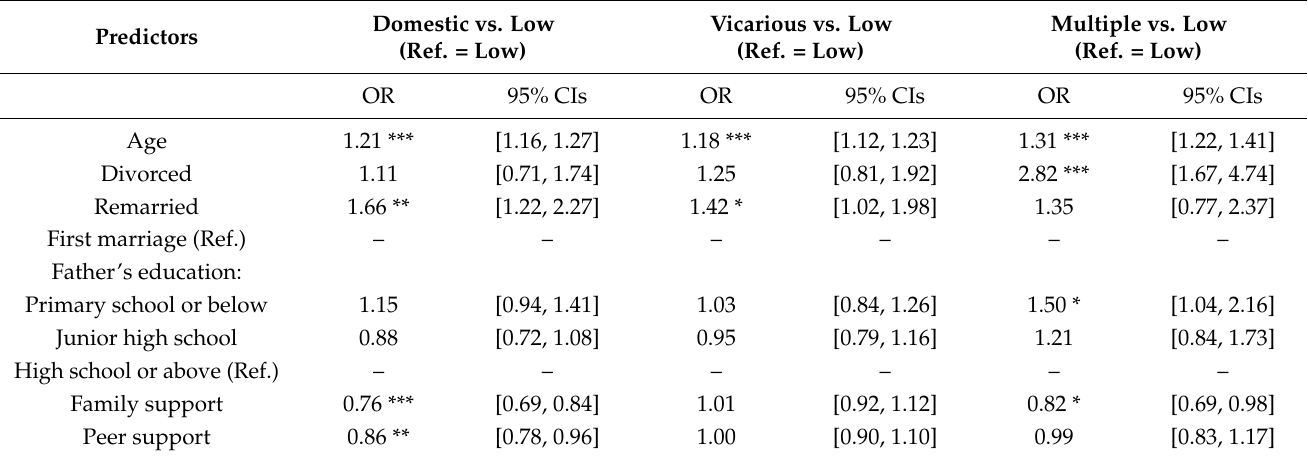
Table 6. Multinomial logistic regressions for predictors of the CTE class membership of females ( N =